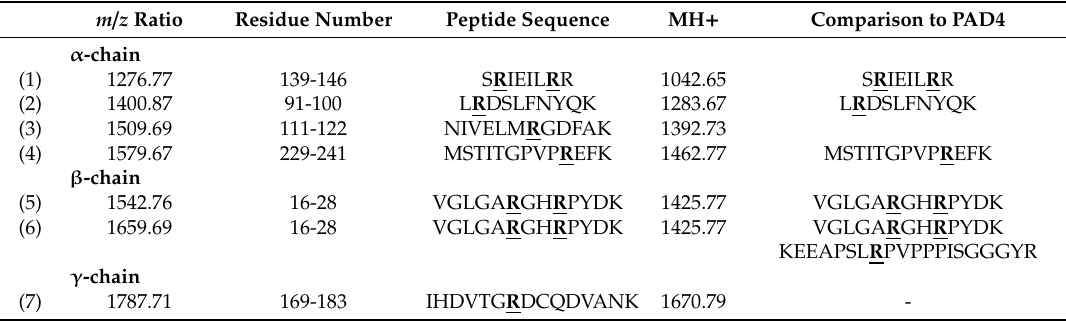
Table 1. Citrullinated peptide sequences in the fibrinogen α , β , and γ